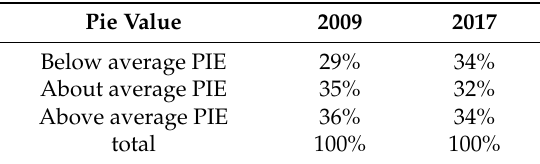
Table 3. Changes in PIE from 2009 to